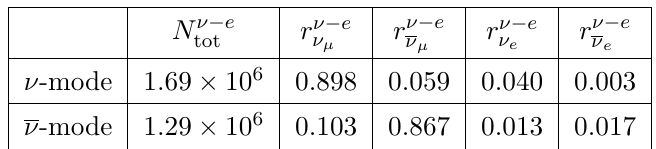
Table 4 . Number of elastic neutrino scattering events on electrons in three years of operation of DUNE ND. We also give the fractional contribution to the total rate of the four